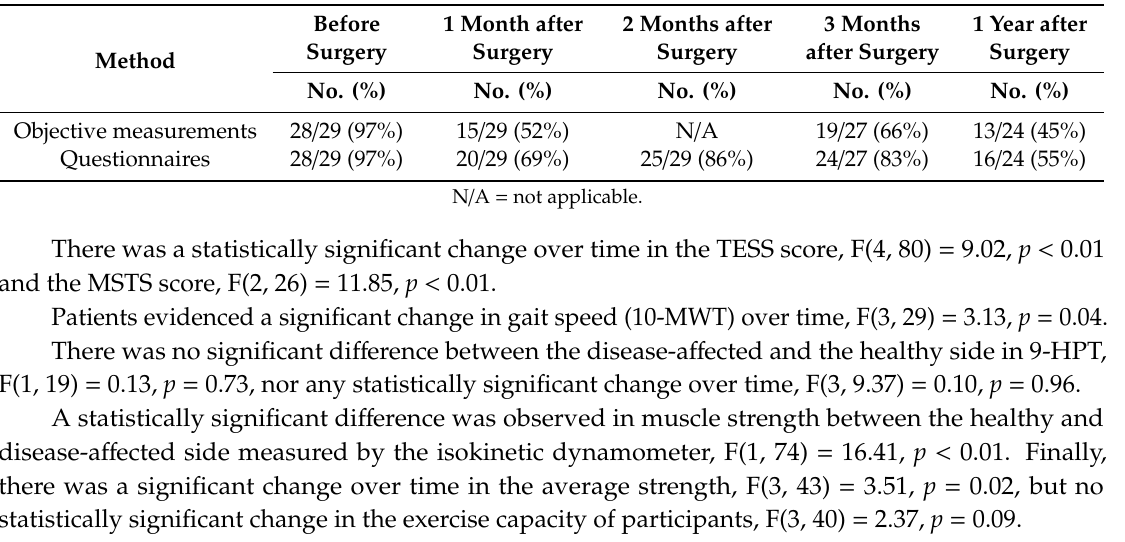
Table 2. The number of patients completing the objective measurements and the questionnaires at each time